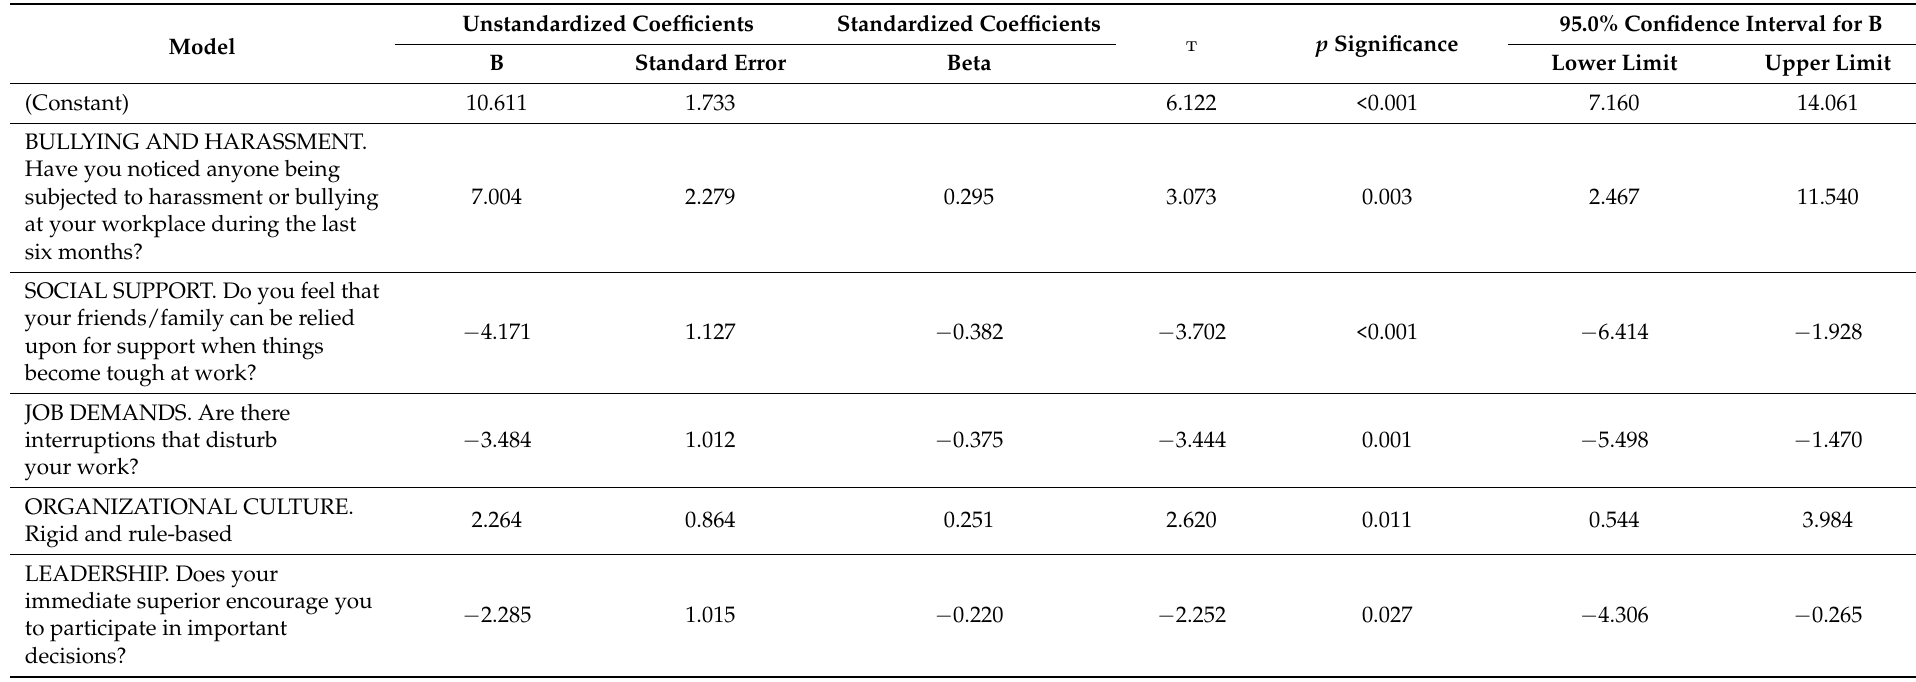
Table 9. Contribution of the assessments of psychosocial factors (coefficients of the regression equation) to loggers’ stress